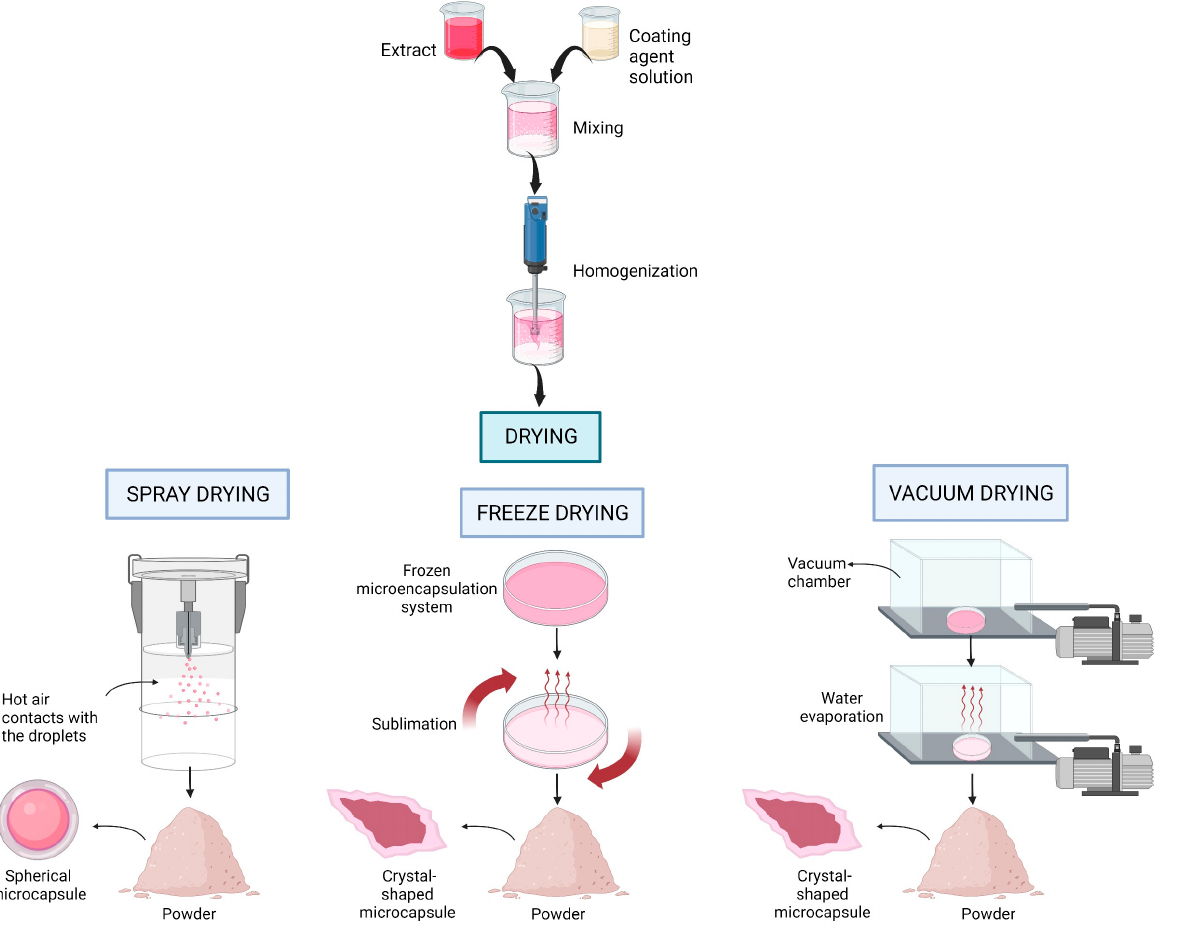
Figure 3. Illustration of the microencapsulation process and the basic principles for the most commonly used drying techniques. Created with BioRender.com (accessed on 26 January 2023). Table 5. C. ternatea extract microencapsulation in diverse methods and coating agents.